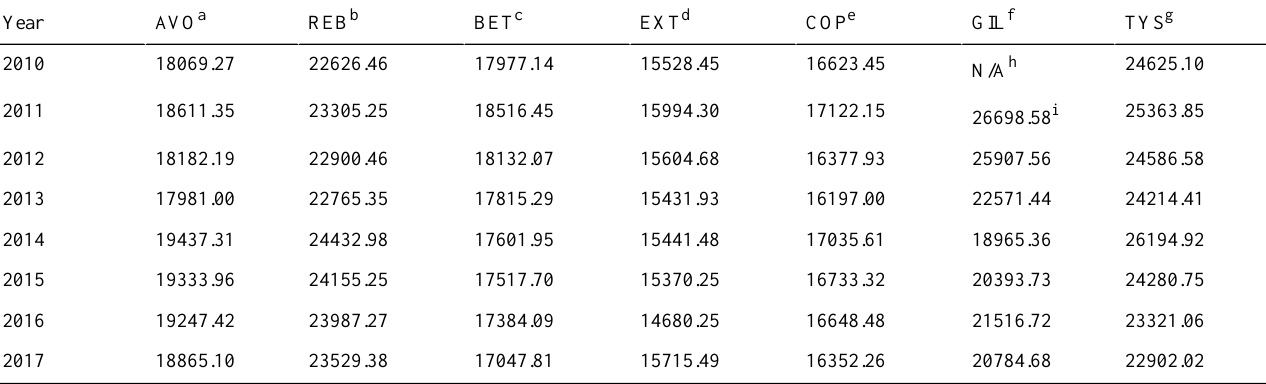
Table 4. Costs of disease-modifying therapies per year (in